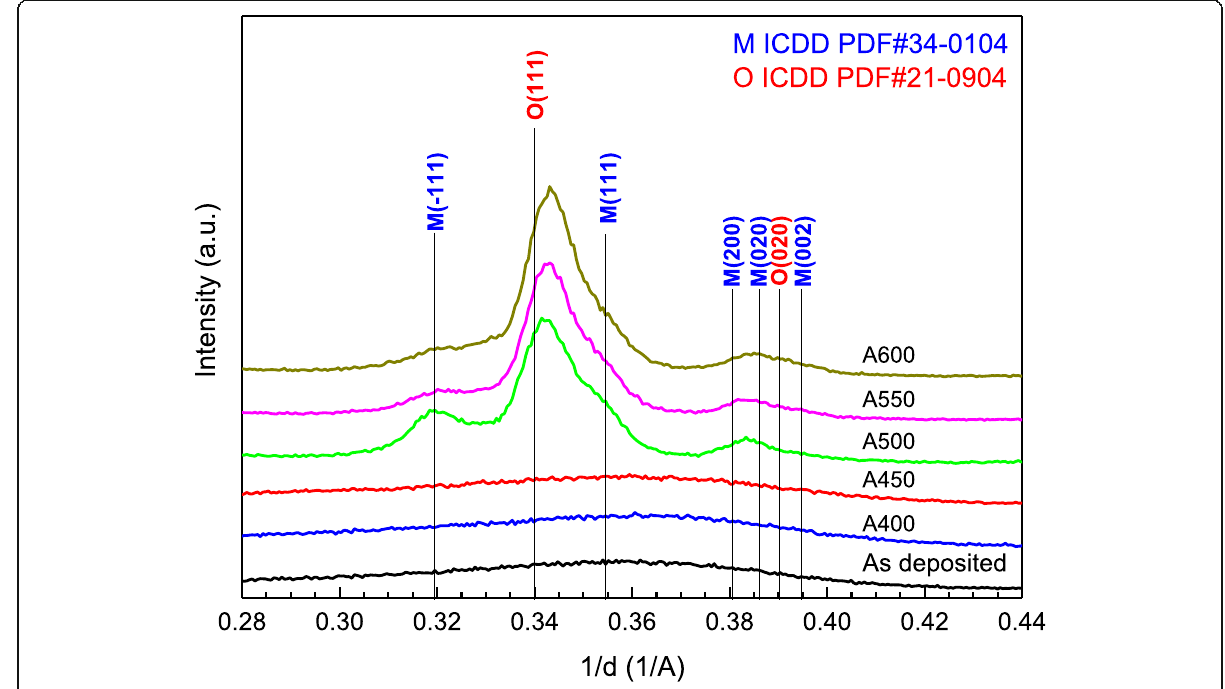
Fig. 2 GIXRD spectra of HfO 2 thin films annealed at different temperatures